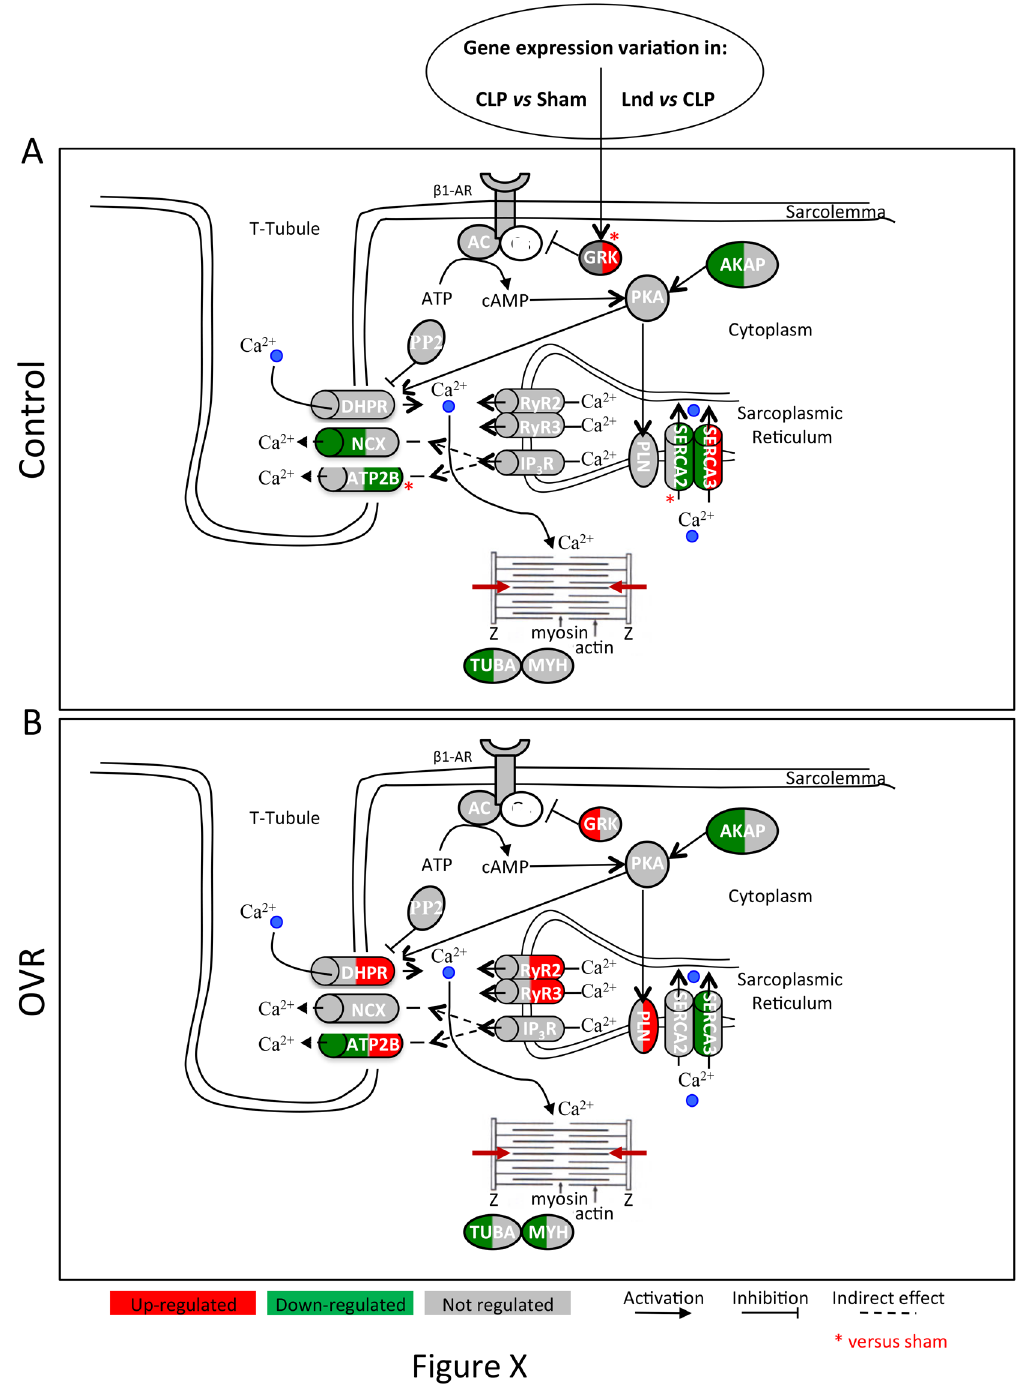
Figure 4. Transcripts regulation by sepsis and landiolol of the adrenergic and excitation/contraction coupling pathways. ( A ) In control females. ( B ) In OVR females. In red: up-regulated, green: down-regulated and grey: not regulated transcripts in sepsis vs sham: left part of symbol, in sepsis + landiolol vs sepsis: right part of symbol; *in sepsis + landiolol vs